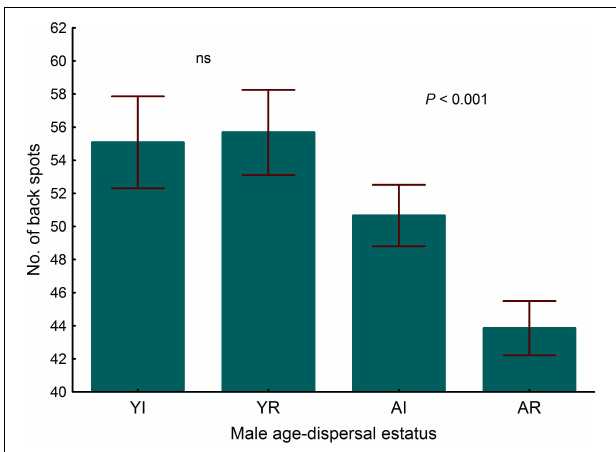
FIGURE 8 | Differences in the number of spots in breeding common kestrel males. YI is young immigrant, YR is young resident, AI is adult immigrant and AR is adult resident. P -values correspond to post-hoc comparisons between groups from the interaction dispersal status x age in the LMMs. Values to the left and to the right correspond to differences in young and adults, respectively. “ns” means not significant differences ( P > 0.05). LMMs: adult, estimate ± s.e . = 6.802 ± 1.55, t = 4.40). Bars and whiskers represent mean and s.e. values, respectively.